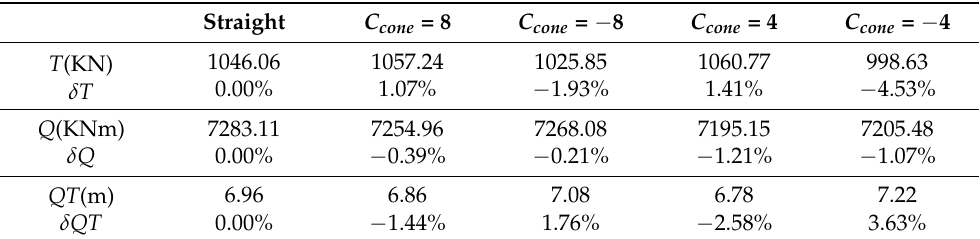
Table 2. Thrust and torque of different configurations (T trans = 5/ R